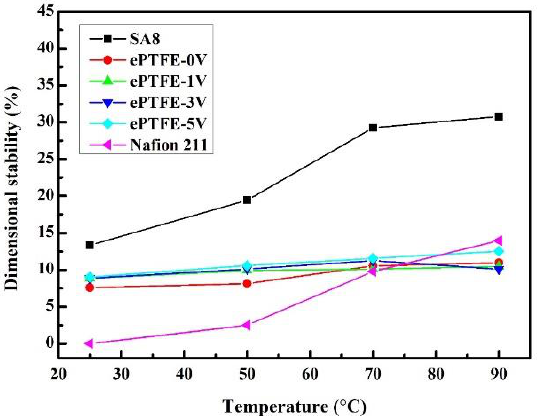
Figure 8. The thickness stability of ePTFE membranes at various temperatures.